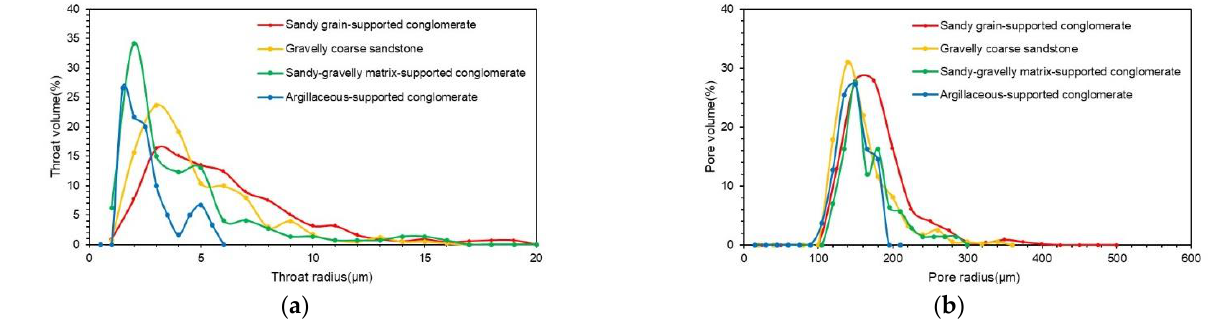
Figure 5. Distribution of pore and throat radius in low permeability conglomerate reservoir. ( a ) Throat radius distribution. ( b ) Pore radius distribution.